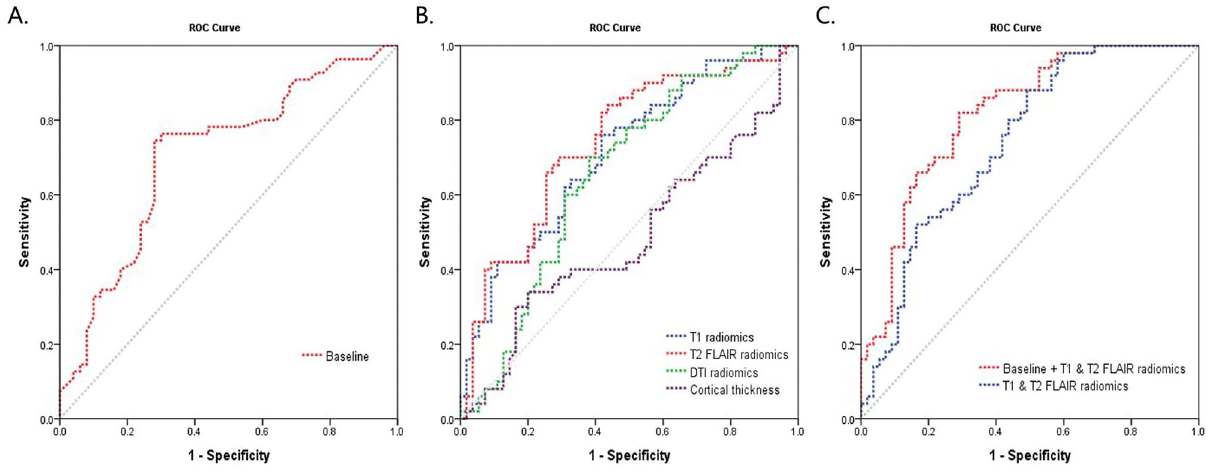
Figure 1. Receiver operative characteristics curves of prediction models. Curves from prediction models using baseline features ( A ), features from single MRI sequence ( B ), and combined features ( C ) were